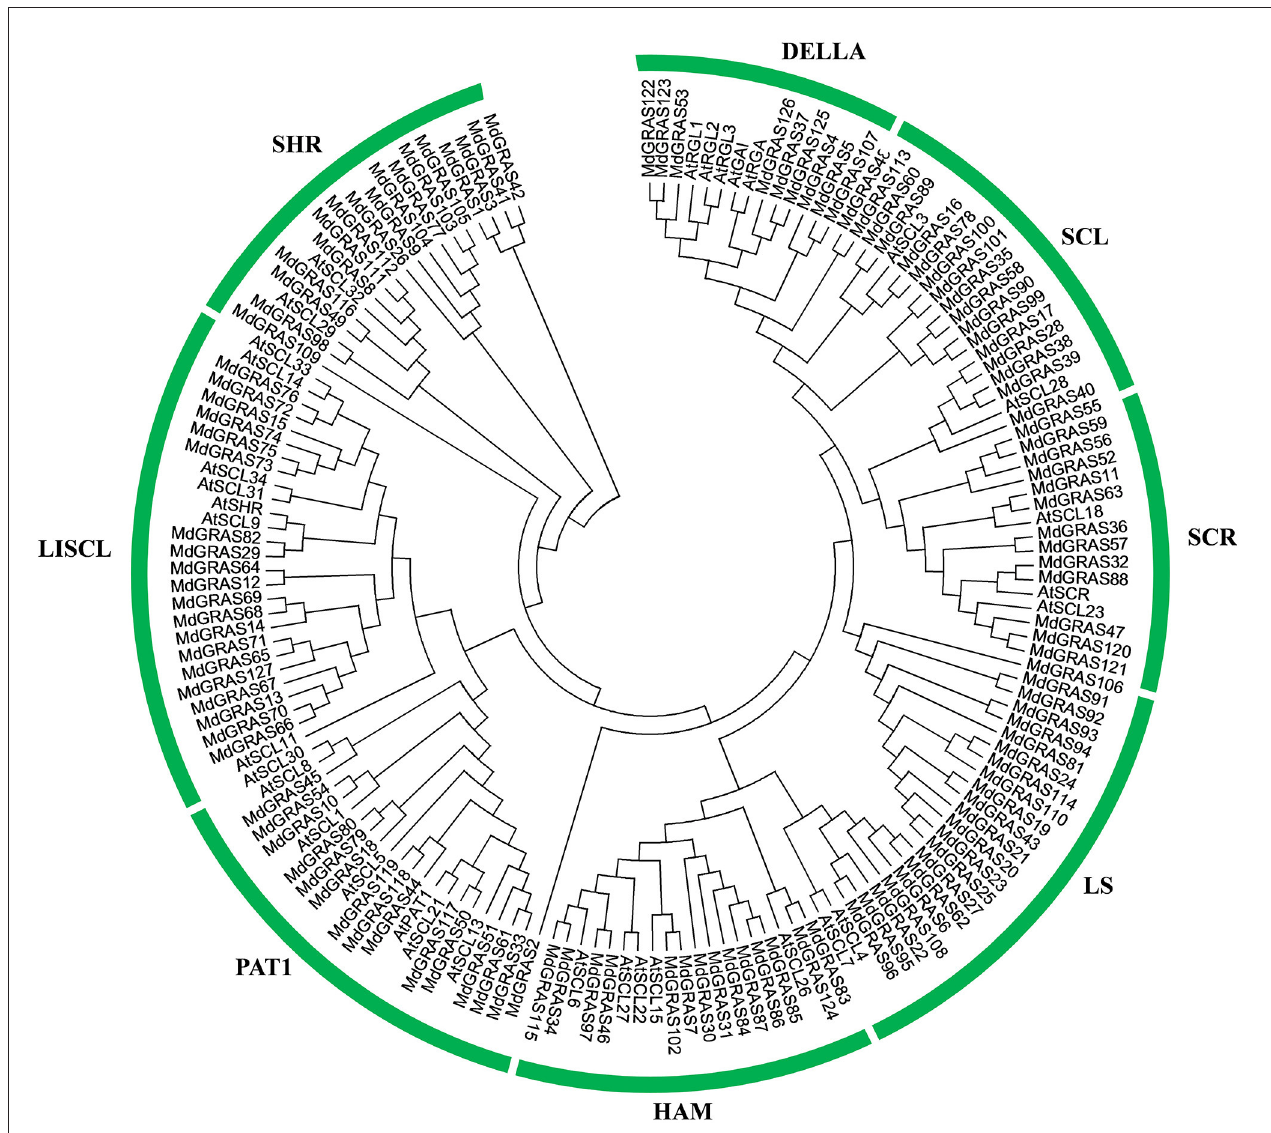
FIGURE 2 | Phylogenetic tree showing the evolutionary relationships of GRAS proteins in apple and Arabidopsis. The phylogenetic tree was conducted using MEGA 5.10. The prefixes At and Md indicate Arabidopsis and apple,